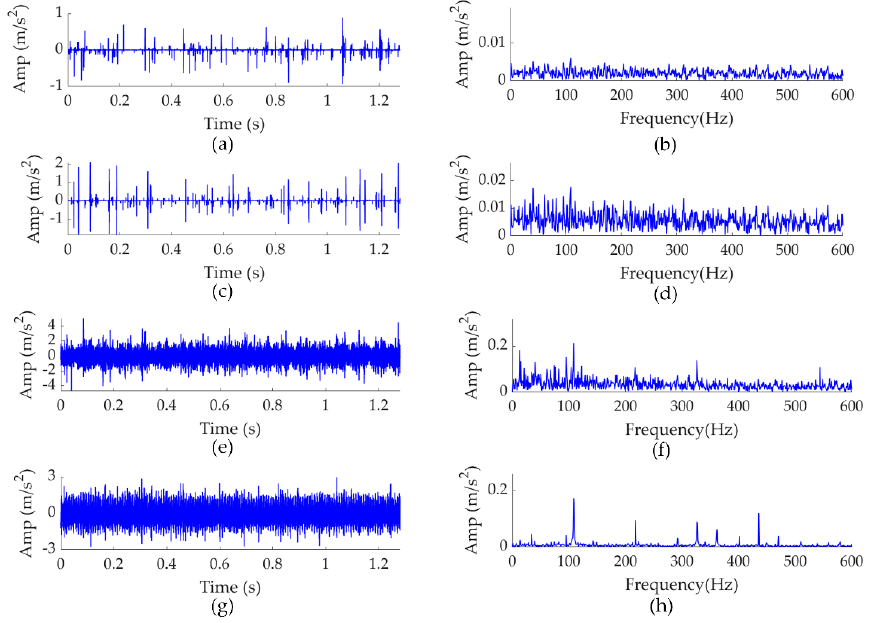
Figure 10. Denoising results of four different methods and their envelope spectra. From top to bottom: L1-Kurtosis ( a , b ), RSVD ( c , d ), VMD ( e , f ), and SRSVD ( g , h ).